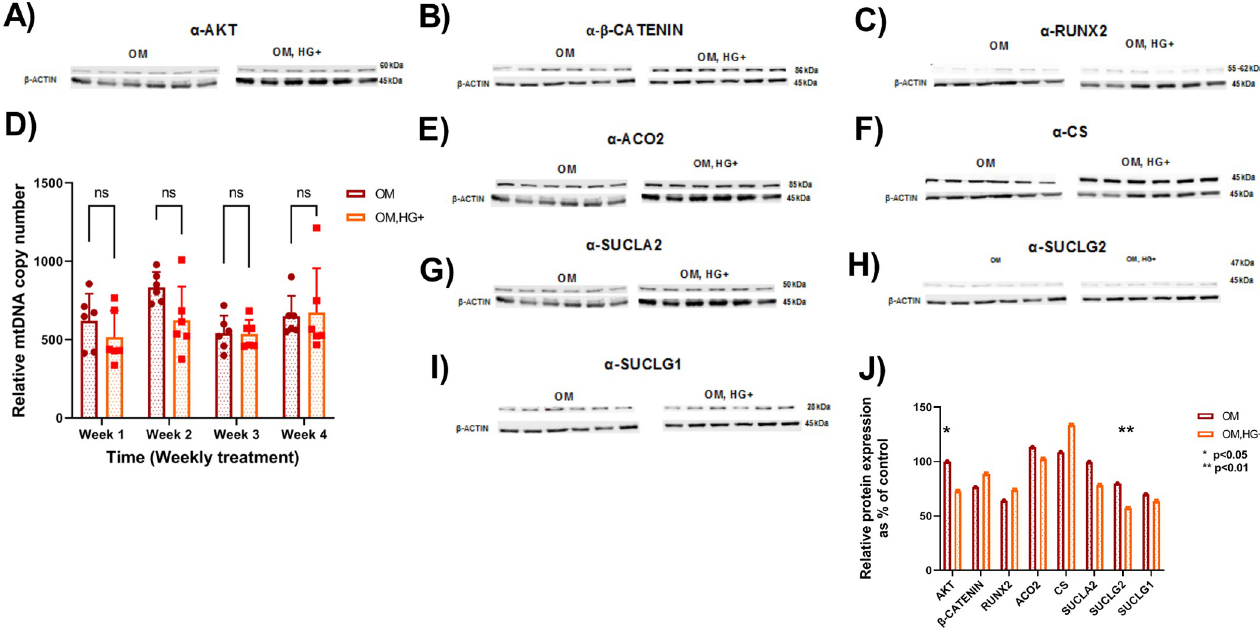
Fig 2. Molecular characterizations of differentiated MC3T3-E1 cells demonstrate altered markers in the presence of high glucose. A. Immunoblot analyses of AKT. B. Immunoblot analyses of β -Catenin. C. Immunoblot analyses of RUNX2. D. mtDNA content was reduced in HG-treated bone cells. E. Immunoblot analyses of ACO2. F. Immunoblot analyses of CS. G. Immunoblot analyses of SUCLA2. H. Immunoblot analyses of SUCLG2. I. Immunoblot analyses of SUCLG1. J. Relative protein expression as percentage of control. All protein lysates for western blot experiments were treated in the presence of low or high glucose for three weeks (week3). Densitometry was measured using ImageJ software and normalized with loading control. Student t-tests were used for data analysis. Asterisk indicates p-value < 0.05. Abbreviations: OM = differentiated cells under low glucose conditions; OM, HG+ = differentiated cells under high glucose conditions. Data represent N = 6 independent experiment per culture condition using one technical